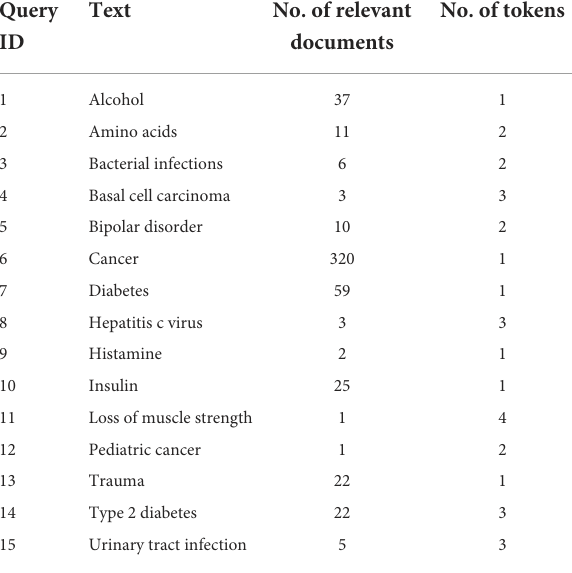
TABLE 3 A description of the queries we used to evaluate the system against PubMed’s BestMatch ranked results were used as a ground